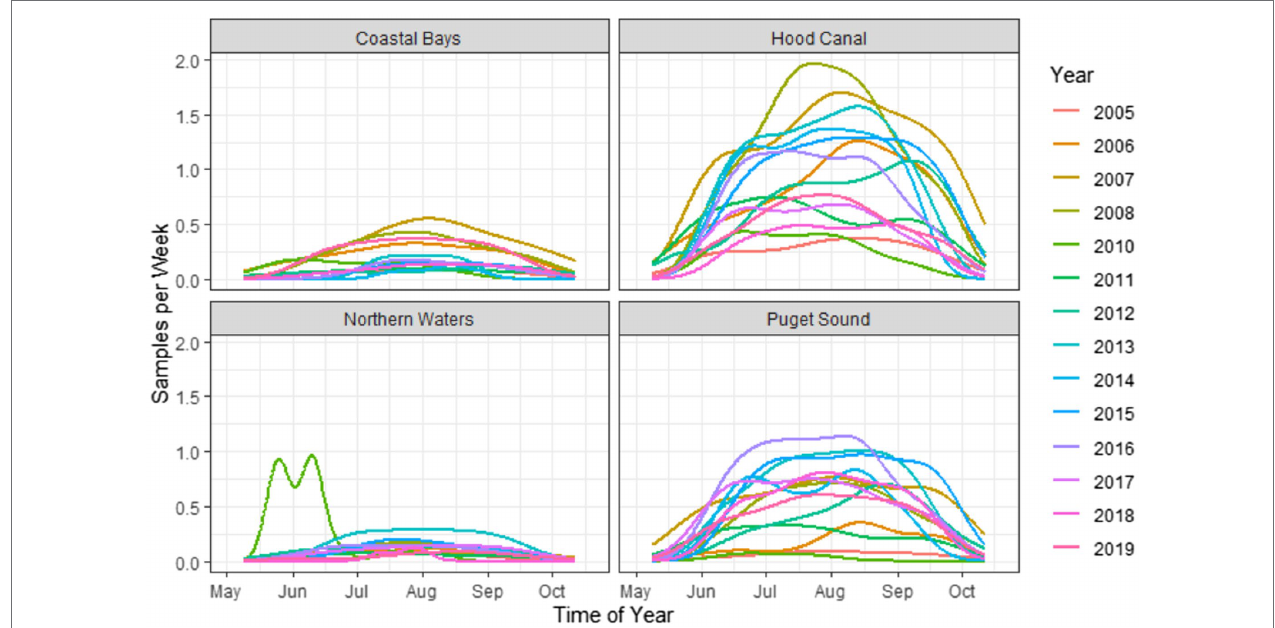
FIGURE 4 | Kernel density plots of weekly sampling across time of year, stratified by zone and year. Note that the estimations are used solely as a visualization tool and not for statistical smoothing, as the number of samples and sampling frequency were not consistent across years.